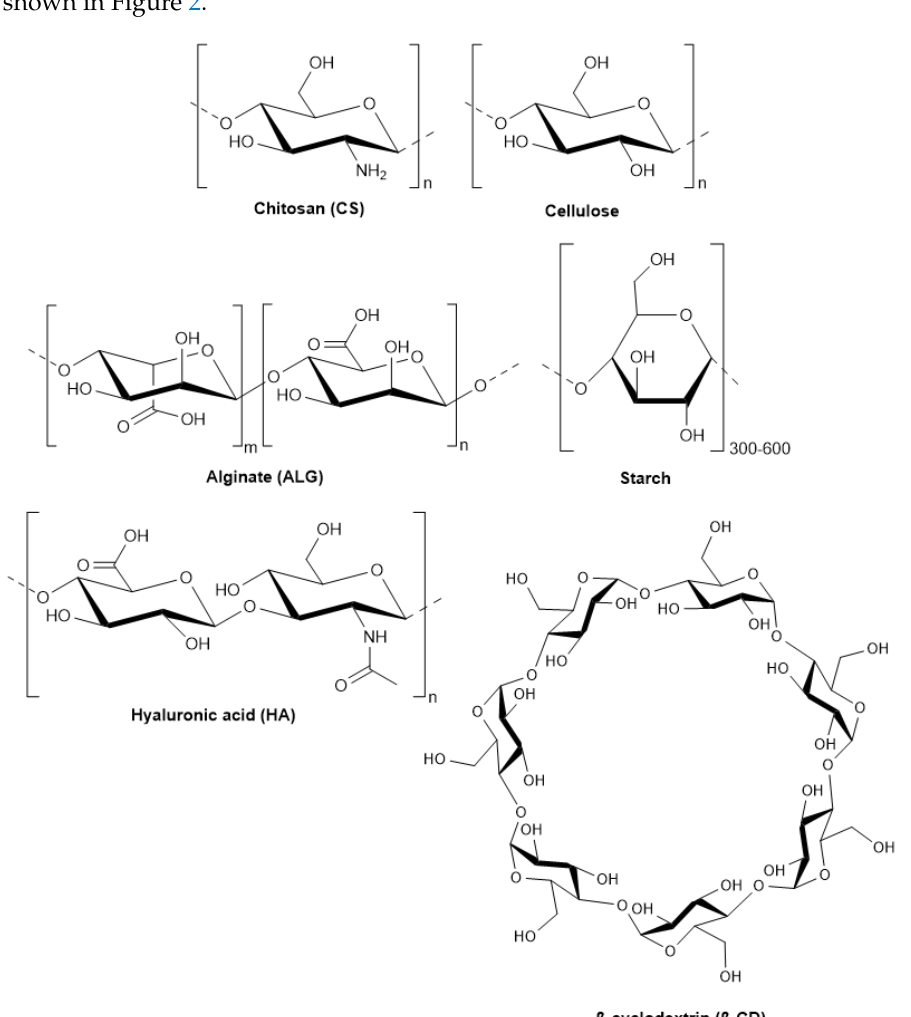
Figure 2. Chemical structure of natural polysaccharides.